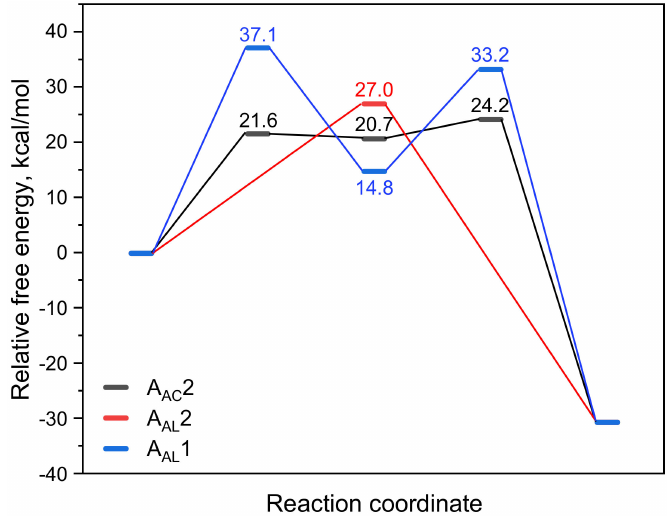
Figure 5. Variation in the relative free energy ( ∆ G ) along the A AC 2, A AL 2, and A AL 1 reaction paths for the acidic hydrolysis of